Question: From the figure, is the trend upward or downward?
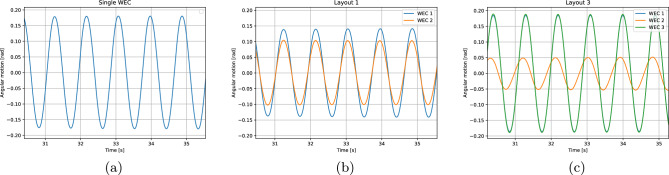
Answer: increasing